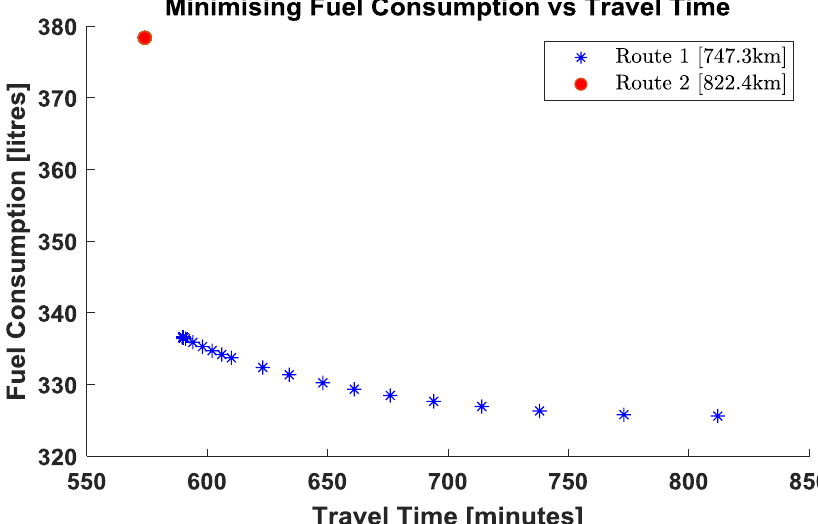
Figure 12. Trade-off between minimising fuel consumption and travel